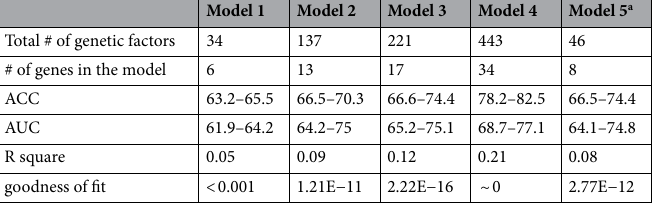
Table 3. Characteristics of GCN-based models. ACC accuracy, AUC area under the curve. a Model created using the approach of